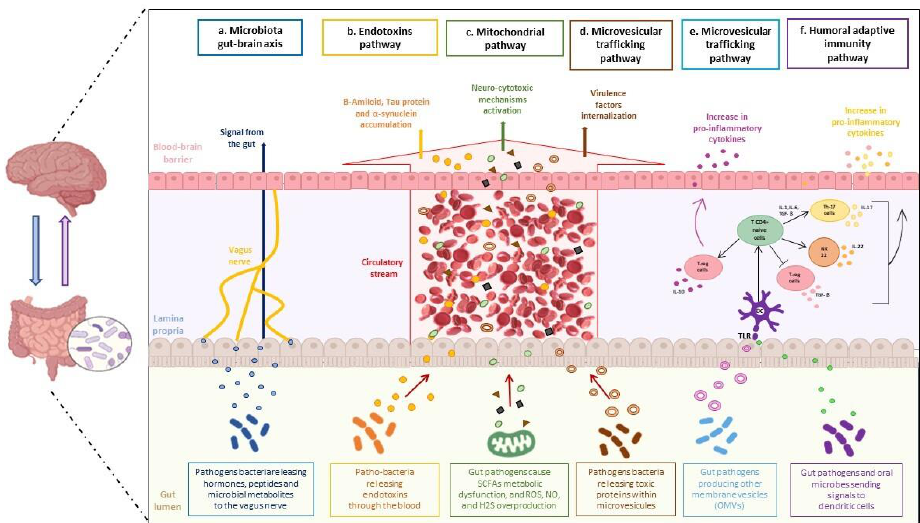
Figure 1. The gut microbiota influences the onset of neurodegenerative diseases. Cooperation between a dysbiotic gut and the central nervous system occurs through several pathways: ( a ) the gut-brain axis, ( b ) endotoxins pathway, ( c ) mitochondrial pathway, ( d , e ) microvesicular trafficking pathway, and ( f ) humoral adaptive immunity pathway. The microbiota gut-brain axis ( a ): pathogenic gut bacteria release hormones and microbial metabolites that reach the brain via the vagus nerve, crossing the blood-brain barrier and inducing neurodegeneration processes. Endotoxins pathway ( b ): endotoxins reach the brain through the bloodstream and cause the accumulation of amyloid β , Tau-protein, and α -synuclein, modulating neuropathology. Mitochondrial pathway ( c ): intestinal pathogens cause SCFAs metabolic dysfunction and increased levels of ROS, NO, and H2S; these altered molecules reach the brain through the systemic circulation and induce activation of neuro cytotoxic mechanisms. Microvesicular trafficking pathway ( d ): pathogenic bacteria release toxic proteins within microvesicles that cross the blood-brain barrier through the bloodstream; this event allows internalization of virulence factors; ( e ) Gram-negative and positive bacteria produce vesicles from their membranes; these vesicles are internalized into dendritic cells and induce the differentiation of T-regulatory cells to produce IL-10, to create a neuroinflammatory environment. Humoral adaptive immunity pathway ( f ): gut microbes internalize pathogenic signals to dendritic cells; differentiation of Th-17 cells and NK-22 cells, and the pro-inflammatory cytokines, as IL-17 and IL-22,occur